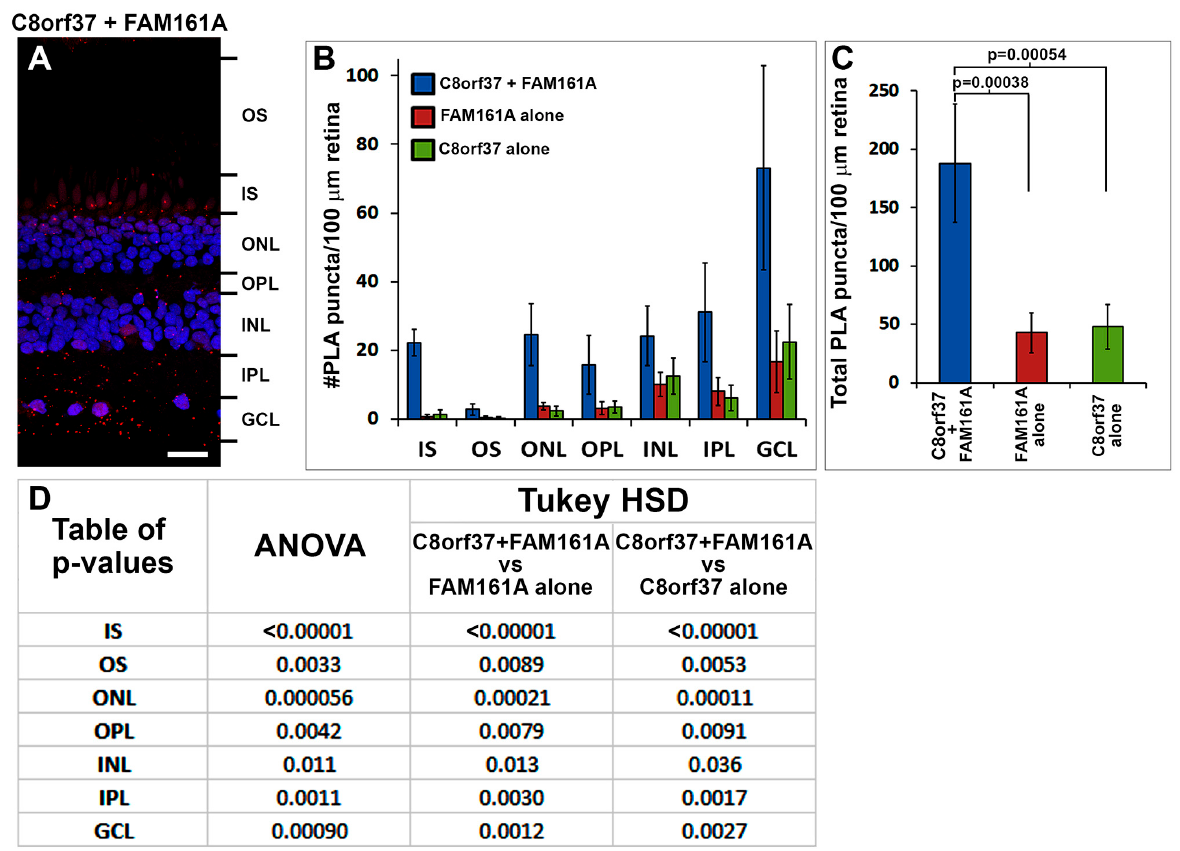
Figure 3. Proximity ligation assay quantification for C8orf37 and FAM161A in the marmoset retina. Confocal images of the retina were divided into layers (example is shown in ( A )). PLA puncta in each layer were counted from images of 5 stained sections from one marmoset eye, showing: ( B , C ) the numbers of PLA puncta in each layer of the retina, as well as the total number of PLA puncta across all layers of the retina. Error bars represent standard error of the mean (SEM). ( D ) Table of p -values from ANOVA and Tukey HSD post-hoc tests. The number of PLA puncta was significantly increased when PLA was performed with both probes compared with when anti-C8orf37-PLUS or anti-FAM161A-MINUS probes were used alone. Scale bar in ( A ): 20 μ m.